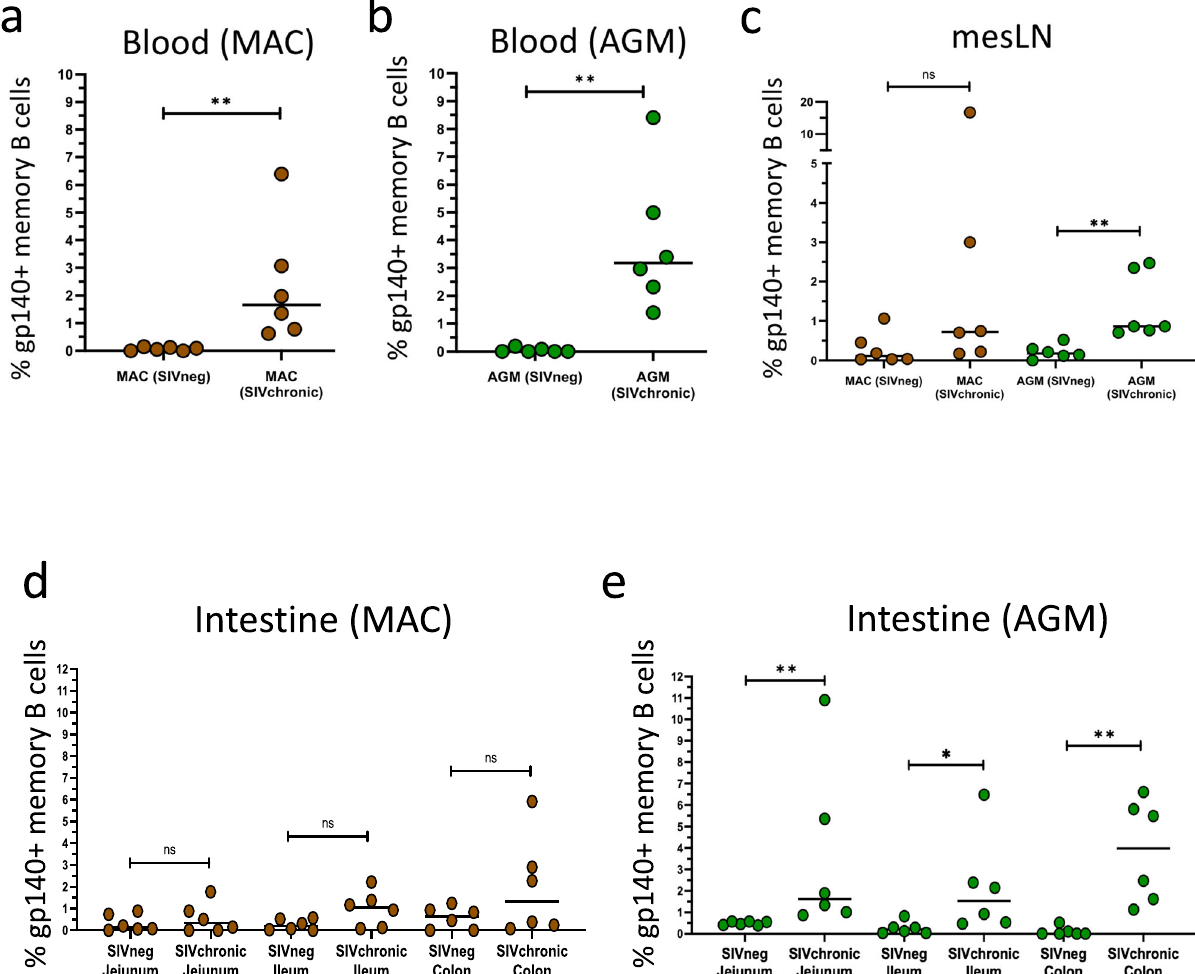
Fig. 4 SIV ENV-speci fi c memory B cells in blood, mesenteric lymph nodes and intestinal tissues during SIVmac and SIVagm infections. a Percentage of GP140-speci fi c memory B cells in blood from MAC (non-infected (SIVneg) and chronically infected (SIVchronic)) ( n = 6 animals). A nonparametric Mann – Whitney test ( p ≤ 0.05 = *; p ≤ 0.01 = **; p ≤ 0.001 = ***) was used. b Percentage of GP140-speci fi c memory B cells in blood from AGM (non- infected (SIVneg) and chronically infected (SIVchronic)) ( n = 6 animals). A nonparametric Mann – Whitney test ( p ≤ 0.05 = *; p ≤ 0.01 = **; p ≤ 0.001 = ***) was used. c Percentage of GP140-speci fi c memory B cells in mesLN from AGM (non-infected (SIVneg) and chronically infected (SIVchronic)) and MAC (non-infected (SIVneg) and chronically infected (SIVchronic)) ( n = 6 animals per species). A nonparametric Mann – Whitney test ( p ≤ 0.05 = *; p ≤ 0.01 = **; p ≤ 0.001 = ***) was used. d Percentage of GP140-speci fi c B cells in the intestine from MAC (non-infected (SIVneg) and chronically infected (SIVchronic)) ( n = 6 animals). A nonparametric Mann – Whitney test ( p ≤ 0.05 = *; p ≤ 0.01 = **; p ≤ 0.001 = ***) was used. e Percentage of GP140-speci fi c B cells in the intestine from AGM (non-infected (SIVneg) and chronically infected (SIVchronic)) ( n = 6 animals).